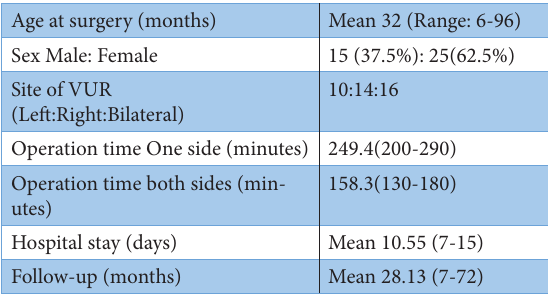
Table 1. Patient